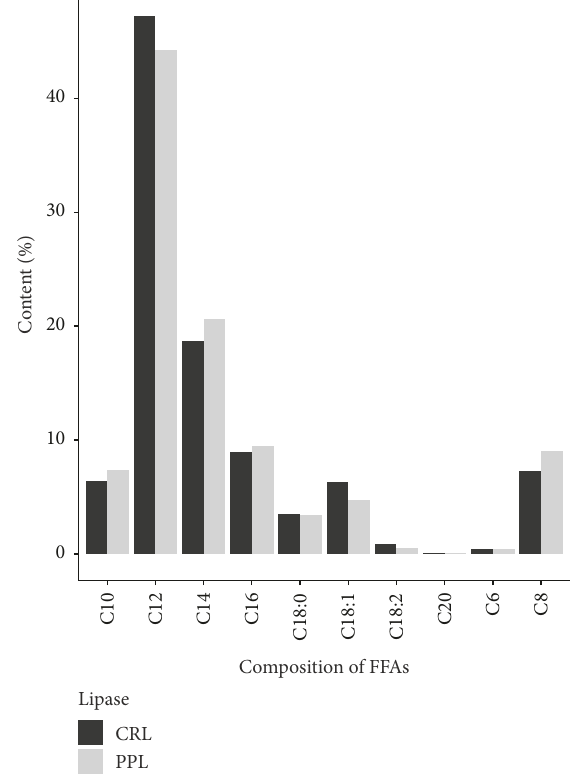
Figure 7: Composition of FFAs obtained after finishing the hydrol- ysis